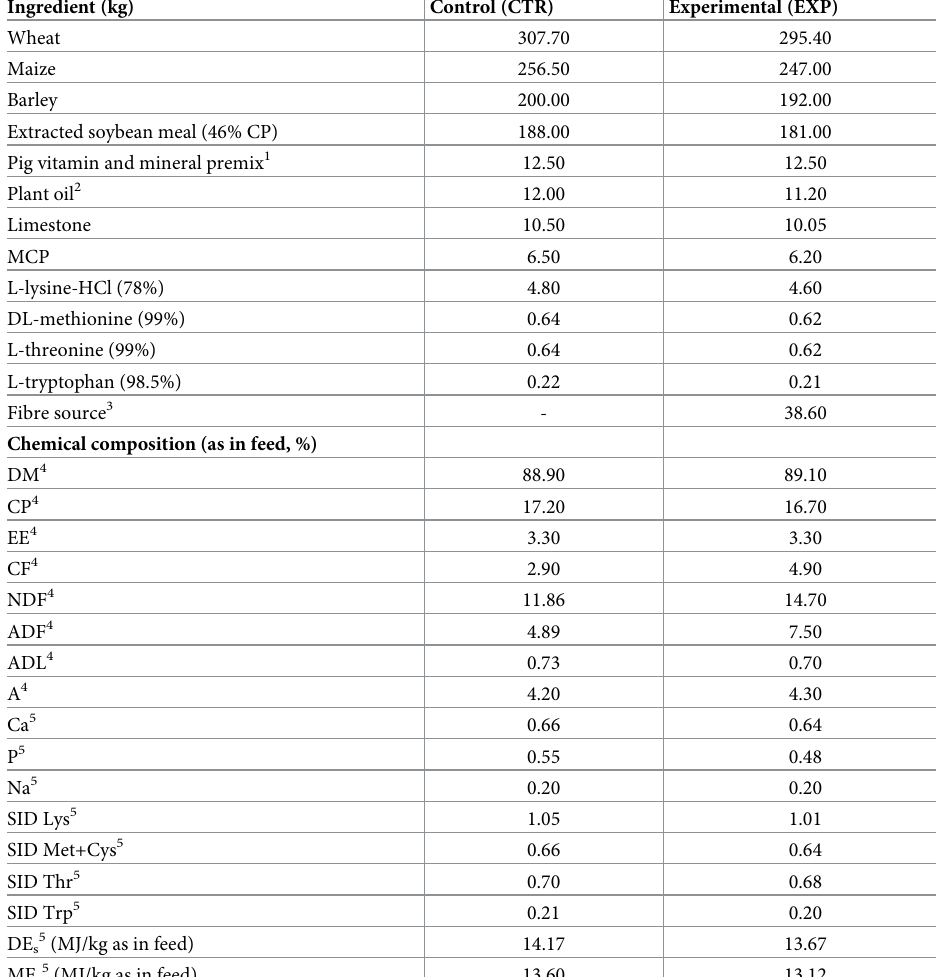
Table 1. Ingredients and the analysed or calculated nutrient and energy content of the control and experimental